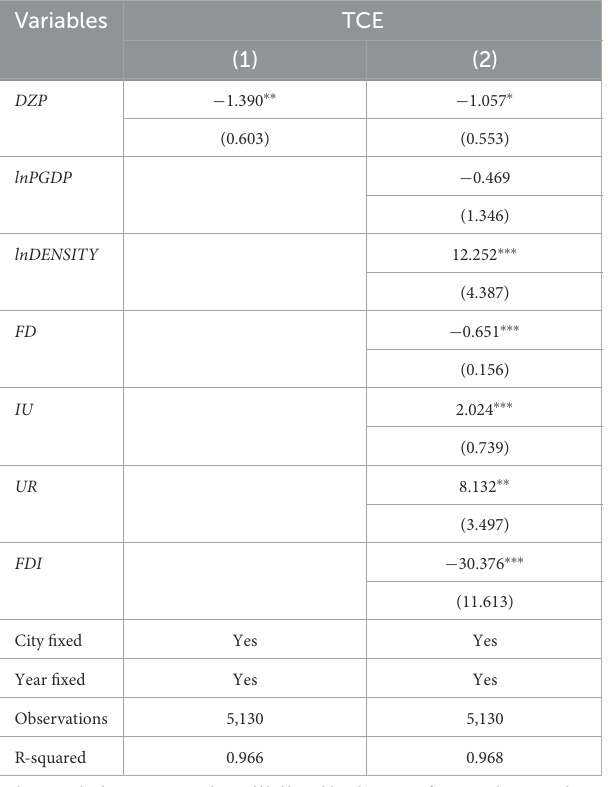
The horizontal axis in Figure 2 represents the years before and after the implementation of the development zone policy. On the other hand, the vertical axis on the same figure depicts its correlation coefficient. For example, t -4 represents the 4th year before the policy implementation, and t + 4 represents the 4th year after the policy implementation. In Figure 2, from year t -5 to year t of the policy execution, the coefficients all contain 0 values within the 95% confidence interval. These results indicate that the development zone policy when implemented and not enforced in the cities have the same time trend and that the effect of the policy on the carbon emissions is insignificant From year t + 1 to year t + 5 of the policy execution, all coefficient values in the 95% confidence interval are <